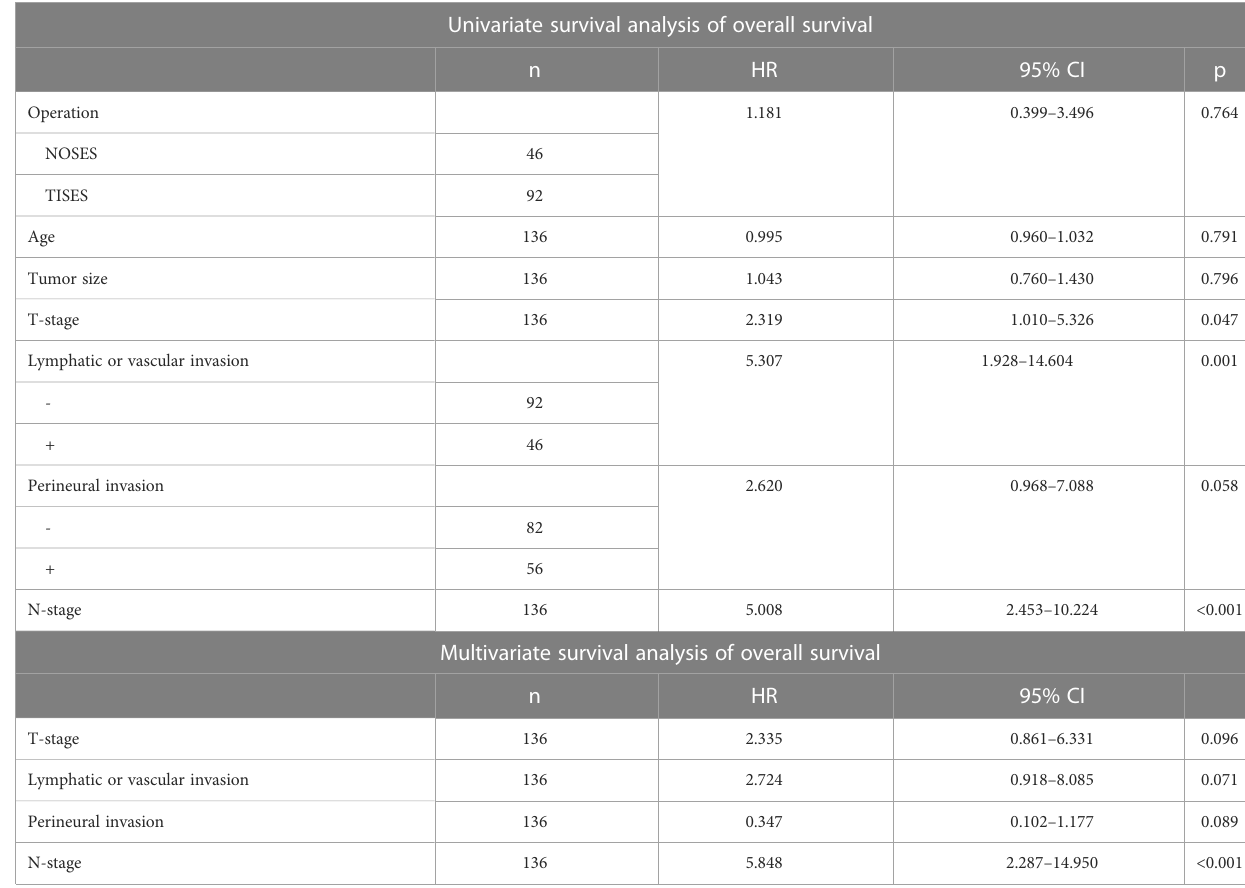
TABLE 5 Univariate and multivariate survival analysis of overall